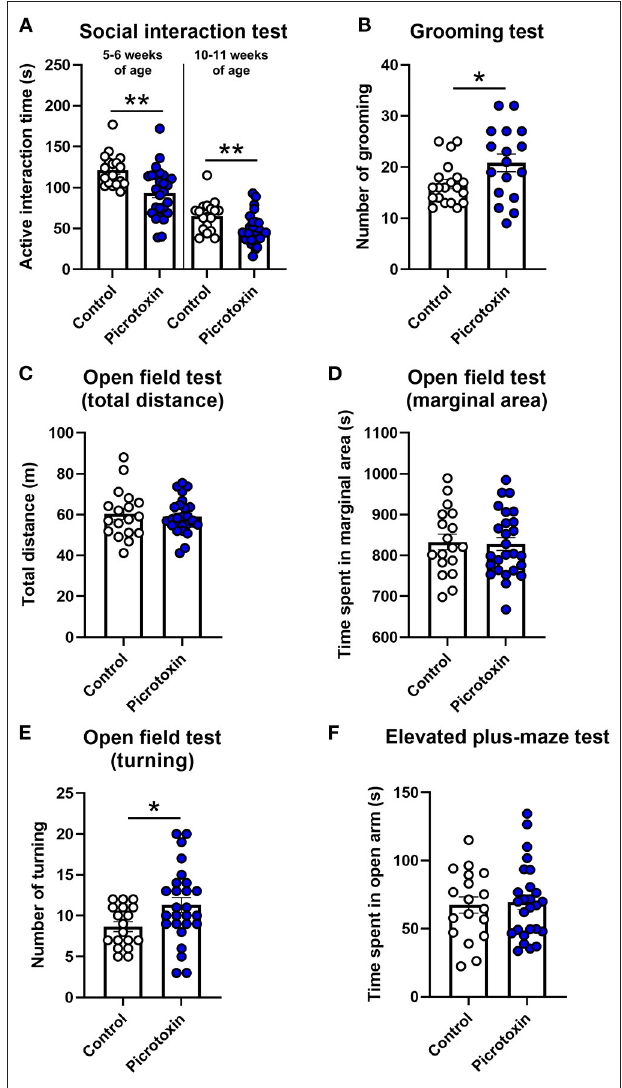
FIGURE 3 | Social interaction, hot plate, grooming, open field, and elevated plus maze tests. (A) Social interaction test. Picrotoxin-exposed male mice exhibited a decrease in active social interaction time compared with control male mice at 5–6 and 10–11 weeks of age. (B) Grooming test. Picrotoxin-exposed male mice exhibited an increase in the number of grooming episodes compared with control male mice. (C,D) Open field test. No significant difference was found between control and picrotoxin-exposed male mice in the total distance traveled (C) or time spent in the peripheral area (D) . (E) Open field test (turning behavior). Picrotoxin-exposed male mice exhibited an increase in the number of turning episodes compared with control male mice. (F) Elevated plus maze test. No significant difference in the time spent on the open arms was found between control and picrotoxin-exposed male mice. The data are expressed as mean ± SEM. ** p < 0.01, * p < 0.05 (unpaired t -test). brain weights to confirm the effects of picrotoxin treatment. No significant difference in brain weight was found between control and picrotoxin-exposed male mice ( Supplementary Results and Supplementary Table 1 ).